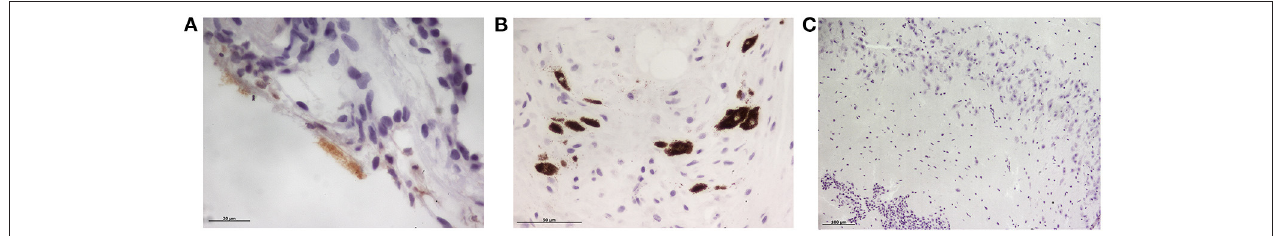
FIGURE 3 | Immunohistochemical detection of SARS-CoV-2 nucleoprotein in mink tissues. (A) Detection of SARS-CoV-2N protein in the olfactory epithelium (x400). (B) Immunodetection for N protein was also detected in olfactory neurons (x400). (C) No immunopositivity was detected in brain samples although viral RNA was amplified by RT-PCR in three animals